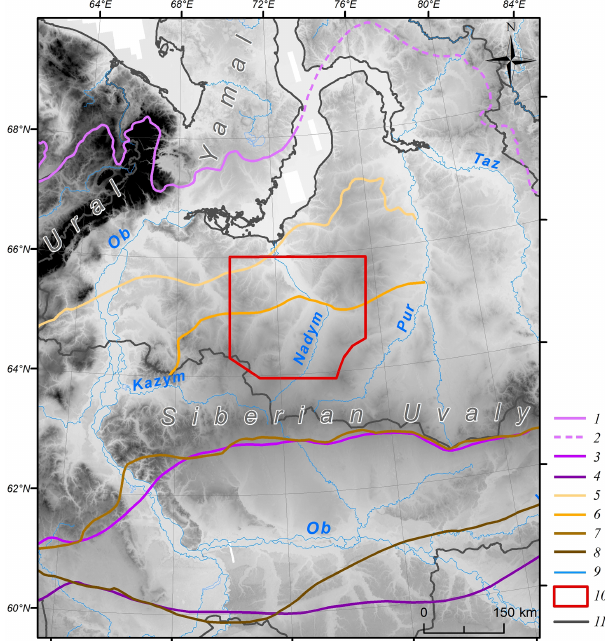
Figure 12. (1–8) Ice sheet boundaries: (1) Zyryanka (Astakhov et al., 2016); (2) Zyryanka (assumed) (Astakhov et al., 2016); (3) Taz (Astakhov et al., 2016); (4) Samarovo (maximum) (As- takhov et al., 2016); (5) Zyryanka (Zemtsov, 1976; Babushkin, 1996); (6) Taz (second stage) (Zemtsov, 1976; Babushkin, 1996); (7) Taz (Zemtsov, 1976); (8) Samarovo (Zemtsov, 1976); (9) wa- ter bodies; (10) study area; (11) administrative boundaries. Back- ground: TanDEM-X 90m DEM ©